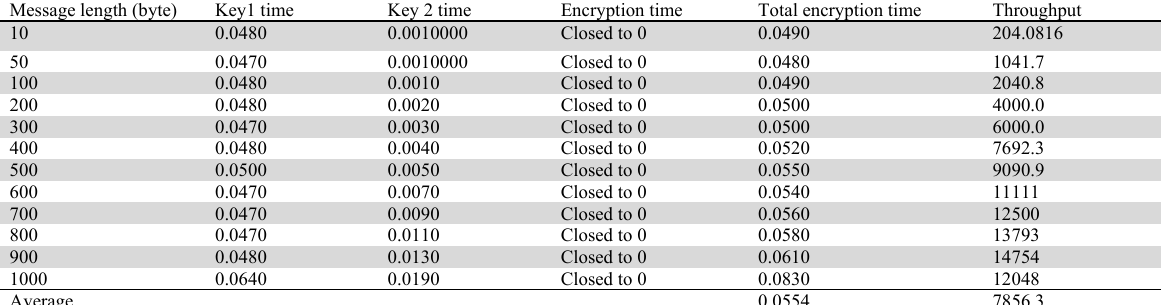
Short messages encryption times (image_key M3) Message length (byte)